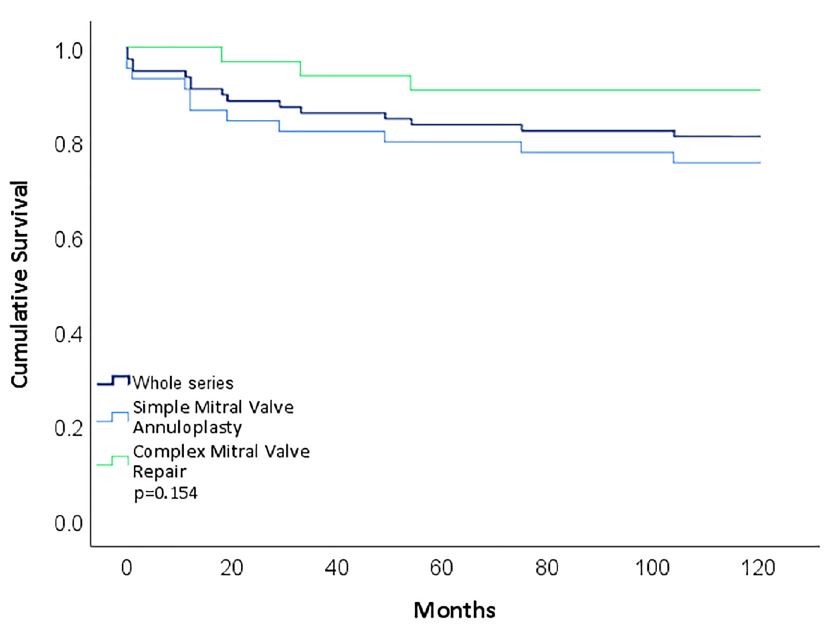
Fig. 1 - Cumulative survival probabilities. Kaplan-Meier estimate of survival function comparing whole series, FMR (simple), and DMR (complex)